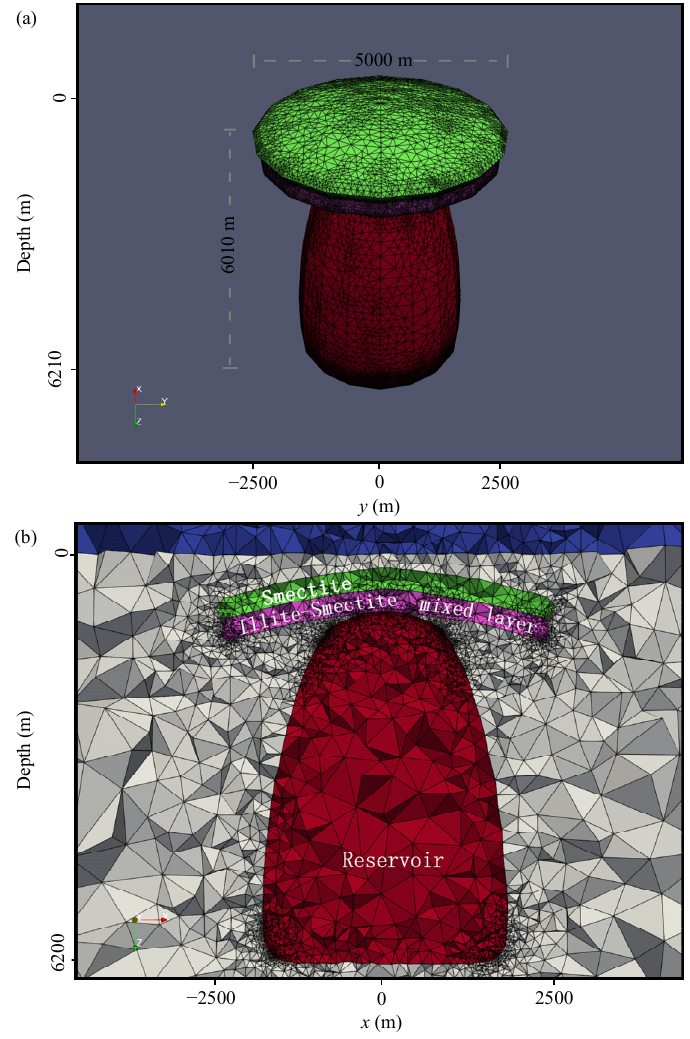
Figure 5. The tetrahedral grids of a typical hydrothermal system. ( a ) The bird’s-eye view of the conductive block. ( b ) The section view at y = 0 m. Table 3. The assigned resistivity values for the hydrothermal system, as shown in Figure 5. The resistivity unit is Ω m.